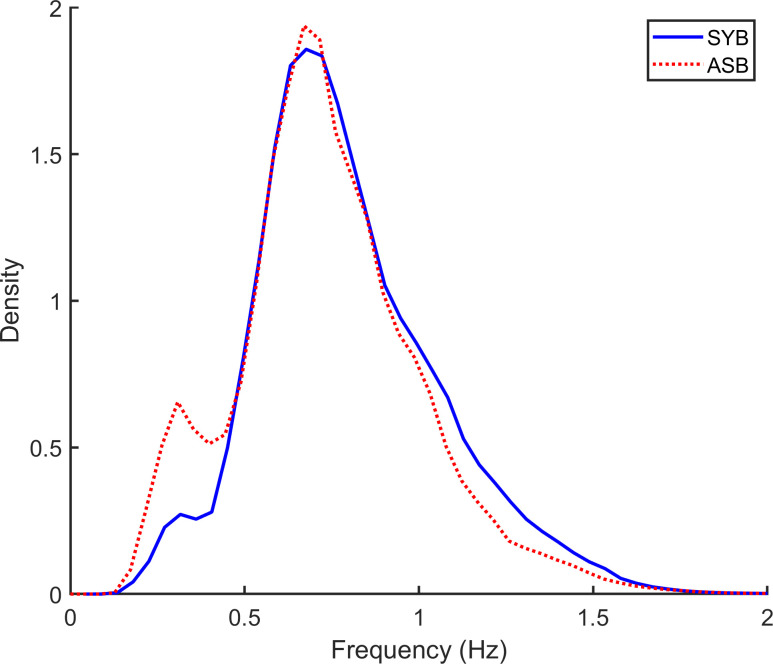
Breathing frequencies.The probability density for the instantaneous frequency for synchronous (SYB) and asynchronous (ASB) samples classified by the automated respiratory event analysis (AUREA).